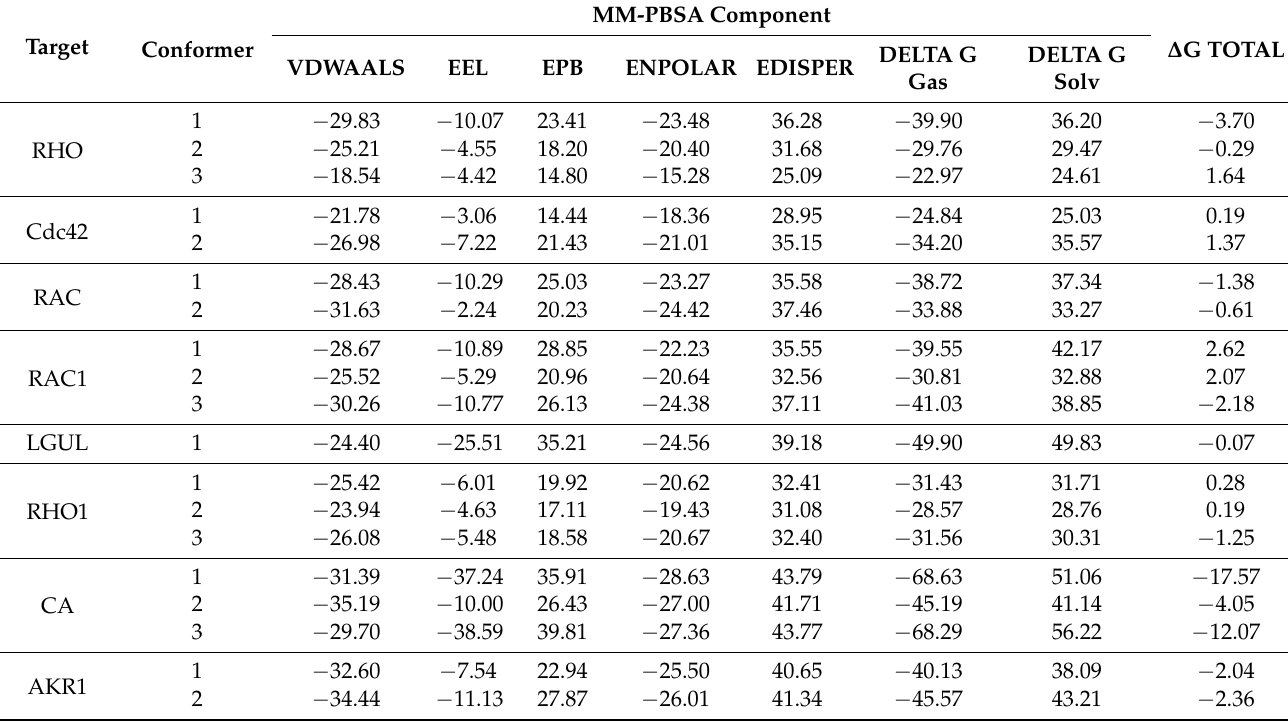
Table 4. Estimated free energies of binding (last column) of compound 8 to its potential targets and their components. Energy values are expressed in